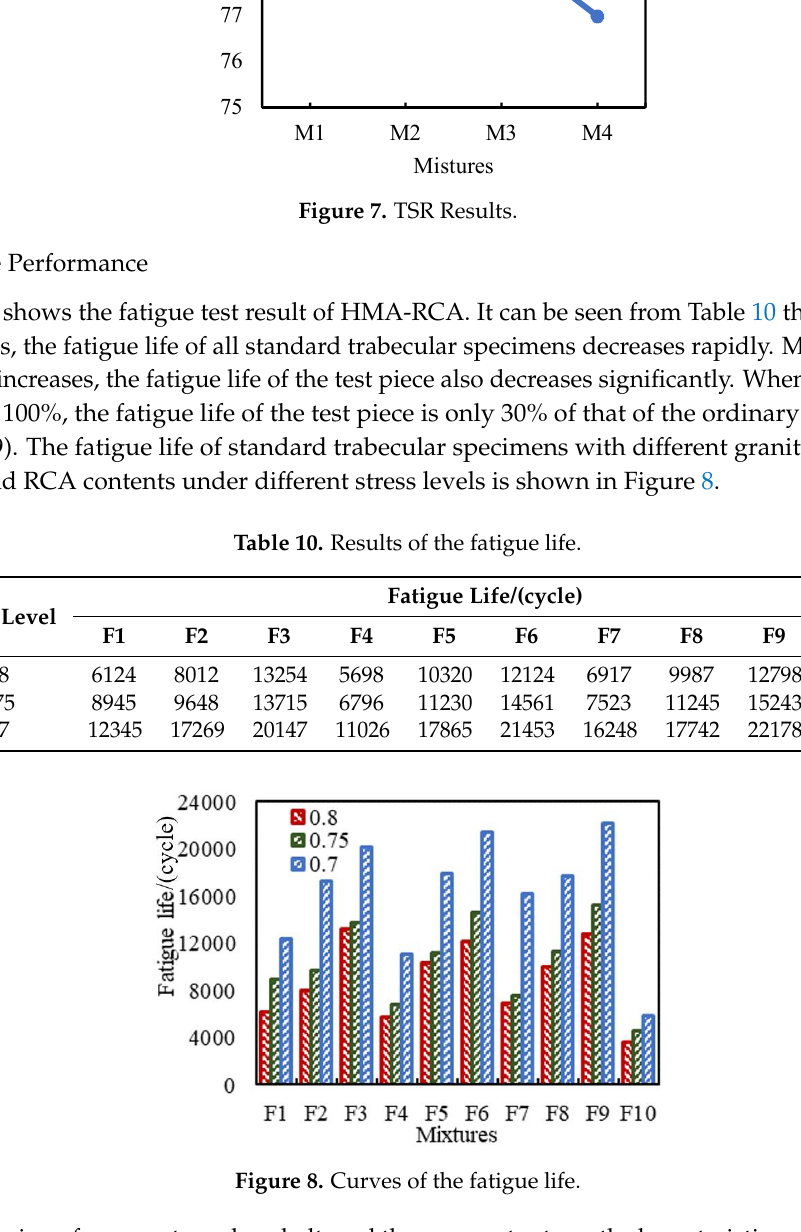
Mistures Figure 7. TSR Results. Figure 7. TSR Results.